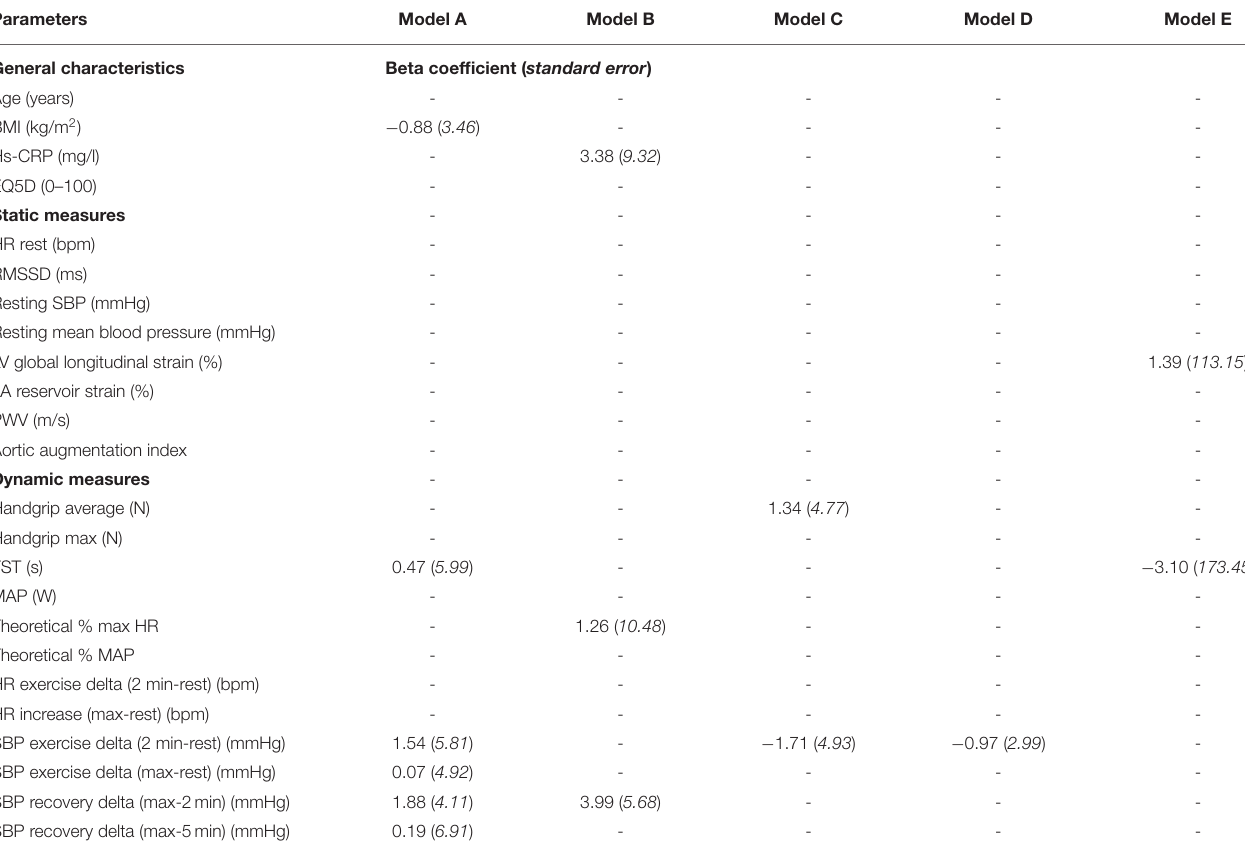
TABLE 3 | The results of five elastic net linear regression models applied to predict heart rate recovery (HRR) 1 and 2 increases (Models A and B) and decreases (Models C, D, and E) post-maximal exercise ECG using the baseline, year 1, and year 2 predictors as independent variables.